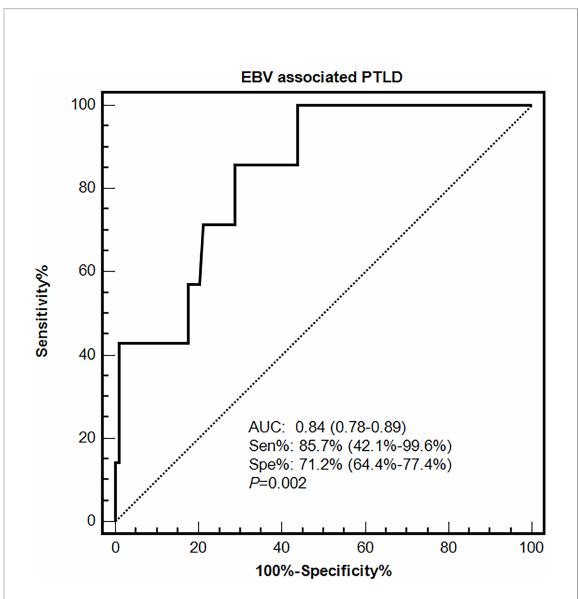
FIGURE 3 Diagnostic value of EBV DNA loads in PBMCs for EBV-associated PTLD disease in the primary cohort.